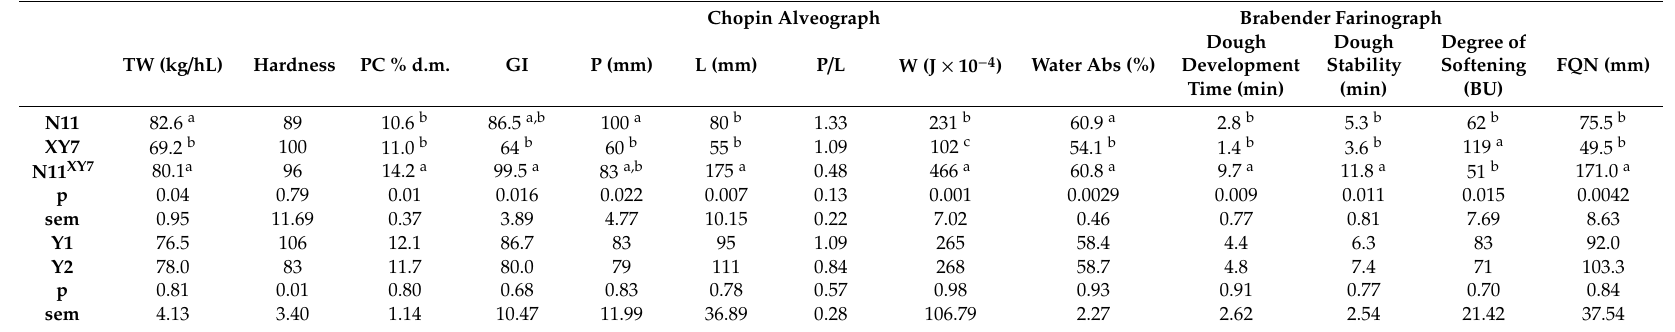
Table 1. Mean of qualitative parameters determined in two di ff erent seasons (Y1: 2016–2017 and Y2: 2017–2018). Chopin Alveograph Brabender